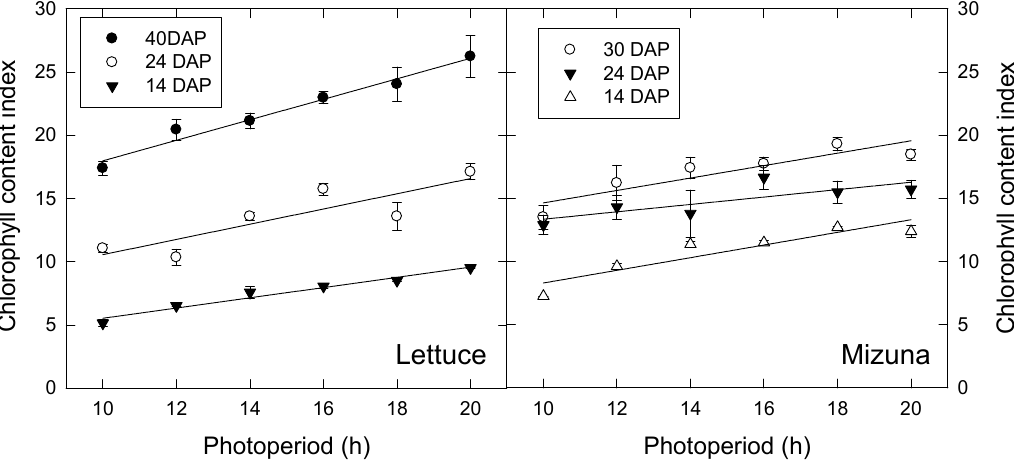
Figure 3. Chlorophyll content index of lettuce ( left ) and mizuna ( right ) grown under varying photoperiods with the same daily light integral of 16 mol · m − 2 · d − 1 . Data shown were collected during the second experiment and on different days after planting (DAP). Data points represent the mean ± SE ( n = 3). Lines indicate significant linear effects of photoperiod ( p < 0.05).